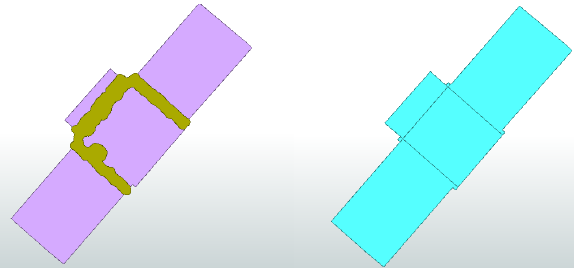
Figure 3. Segmentation of the 2D footprint using concave angles. On the left: breakline-zones identified using LIDAR data. On the right: lines created as a continuation of the lines creating concave angles